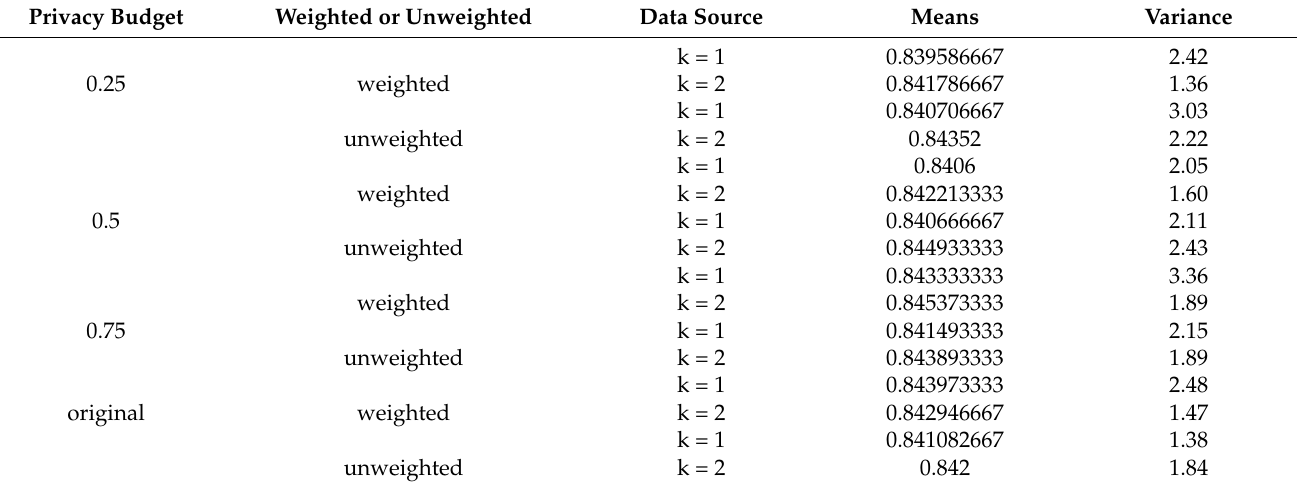
Table 6. The stacking ensemble performance of the initial global model H 2 for the t 3